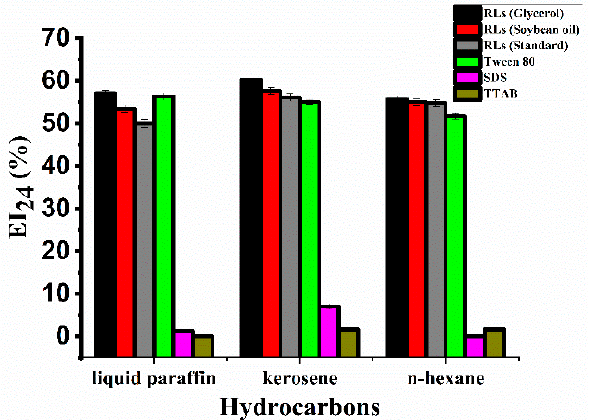
Figure 4. The emulsification index at 24 h (EI 24 ) of surfactants in the different hydrocarbons. To measure EI 24 , 5 mL of surfactant solution was added to 5 mL of hydrocarbons in a glass test tube; the mixture was vortexed at high speed for 2 min, and incubated at room temperature for 24 h. The concentration of all surfactants was 500 mg/L. The error bars represent standard deviations from three independent experiments ( n =